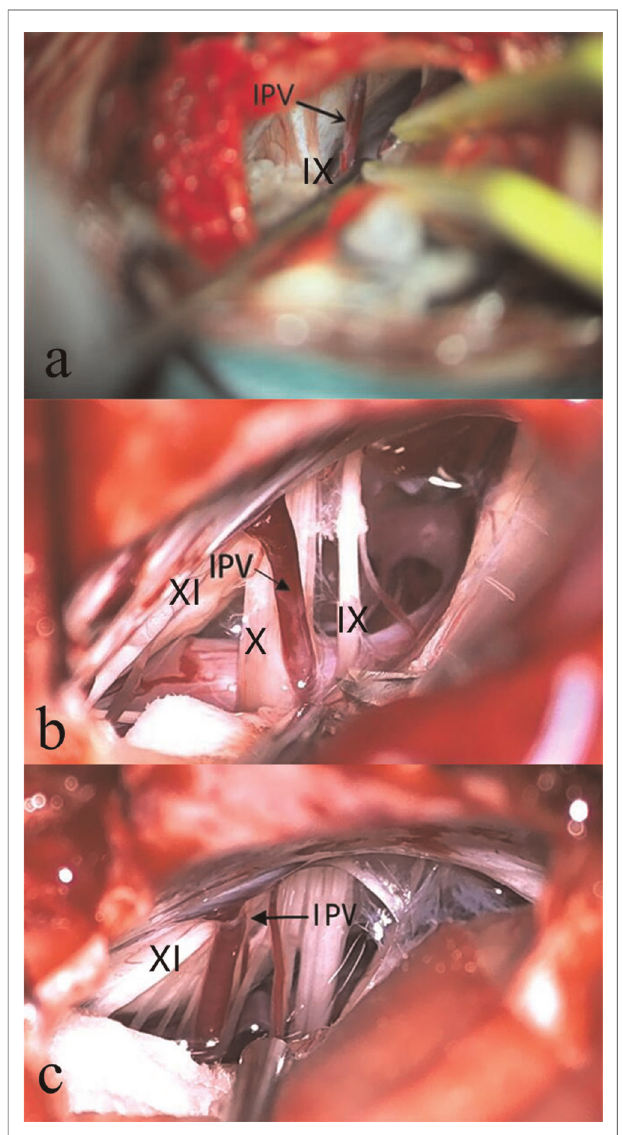
FIGURE 3 | IPV Draining Points. The con fl uence of IPV and jugular bulb can be at or above the level of the glossopharyngeal nerve ( A ), at the level of the vagus nerve ( B ), or the level of the accessory nerve ( C ). IX, Glossopharyngeal Nerve; X, Vagus Nerve; XI, Accessory Nerve; IPV, Inferior Petrosal